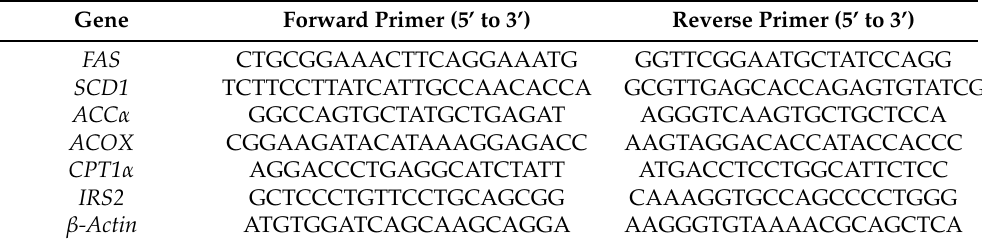
Table 4. Primers used in quantitative real-time